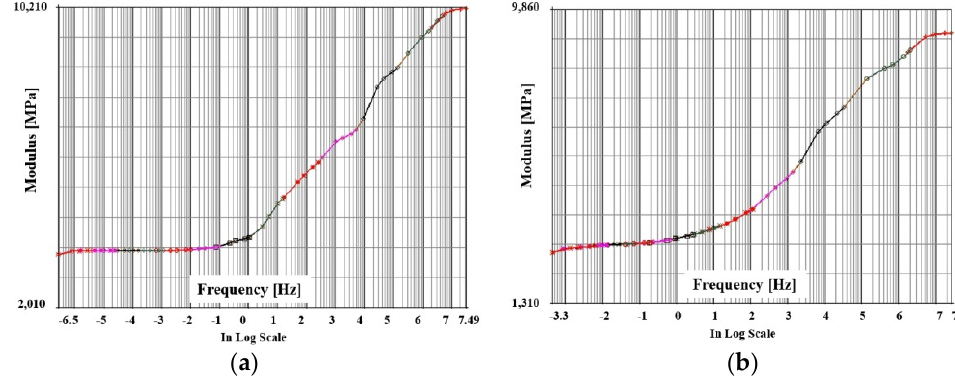
Figure 11. Master curve of PPG under curing as a function of frequency: ( a ) x direction; ( b ) Y direction.